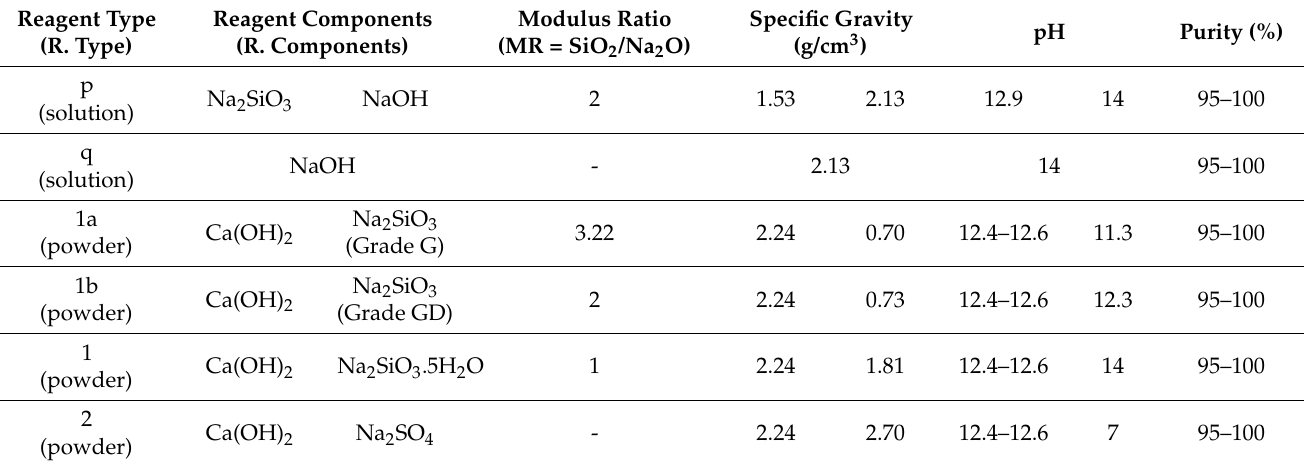
Table 2. Physical and chemical properties of reagents.